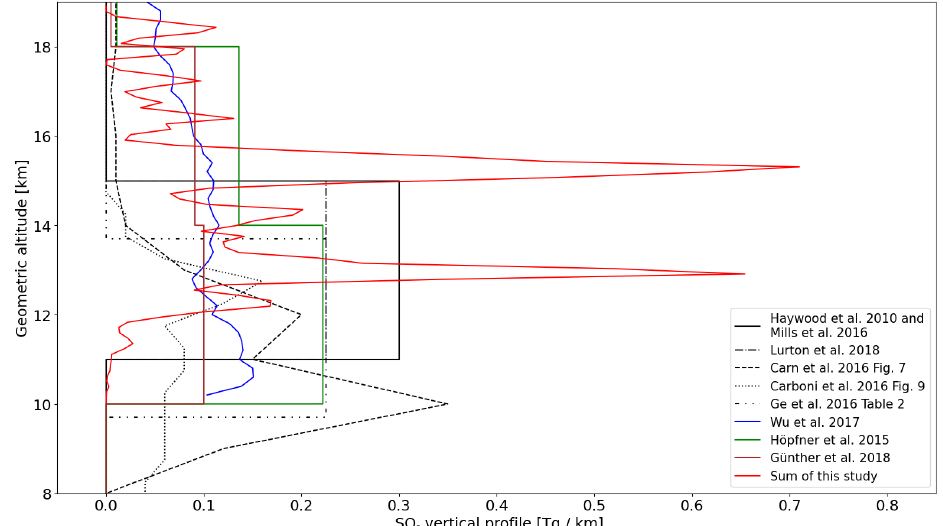
Figure 8. SO 2 profiles from other studies compared with the sum of our profiles from Fig. 7c. The emissions in the model studies were released as follows: Haywood et al. (2010) – 15–16 June 2009; Lurton et al. (2018) – 15 June 2009; Ge et al. (2016) – 11 June 2009; Günter el at. (2018) – 12 June 2009; and Höpfner et al. (2015) – 12 June 2009. For Carn et al. (2016) and Carboni et al. (2016), the data closest in time to our dataset were used. In Wu et al. (2017), SO 2 emissions are integrated between 12 and 16 June